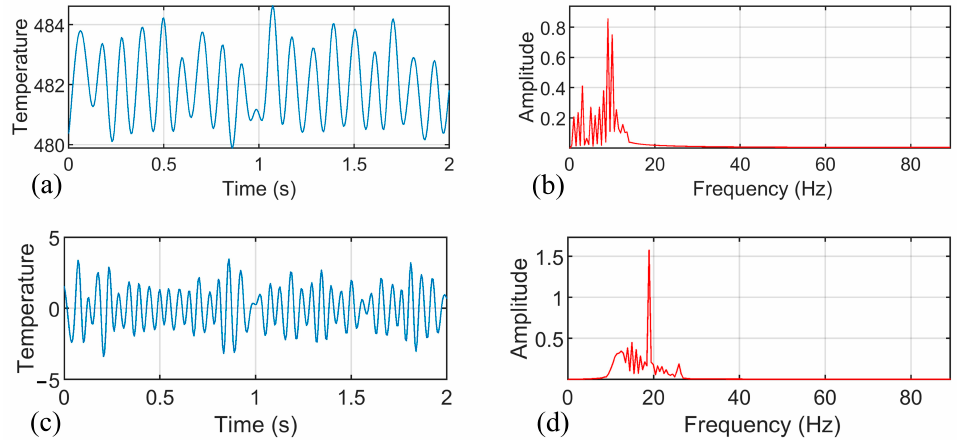
Figure 6. Temperature signal component of perfectly formed welds: ( a ) Temperature signal component decomposed by wavelet packet at node 7; ( b ) Spectrum of temperature signal component at node 7; ( c ) Temperature signal component decomposed by wavelet packet at node 8; and ( d ) Spectrum of temperature signal component at node 8.